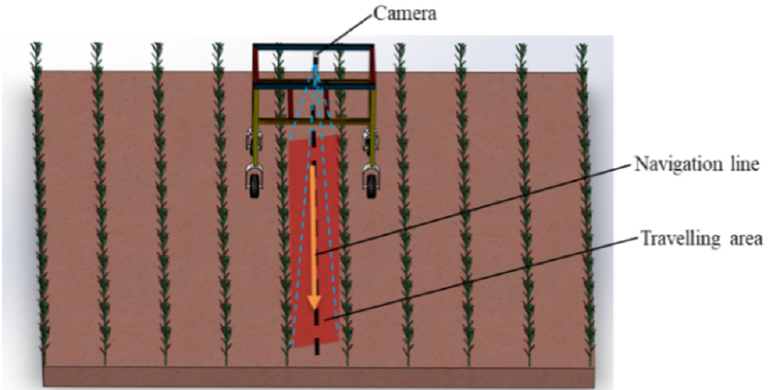
Figure 1. Navigation of agricultural robot in fields.